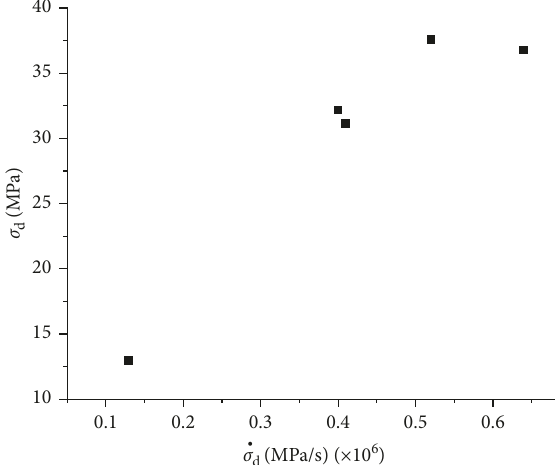
Figure 5: Relationship between dynamic tension strength and loading rate at depth 360m.